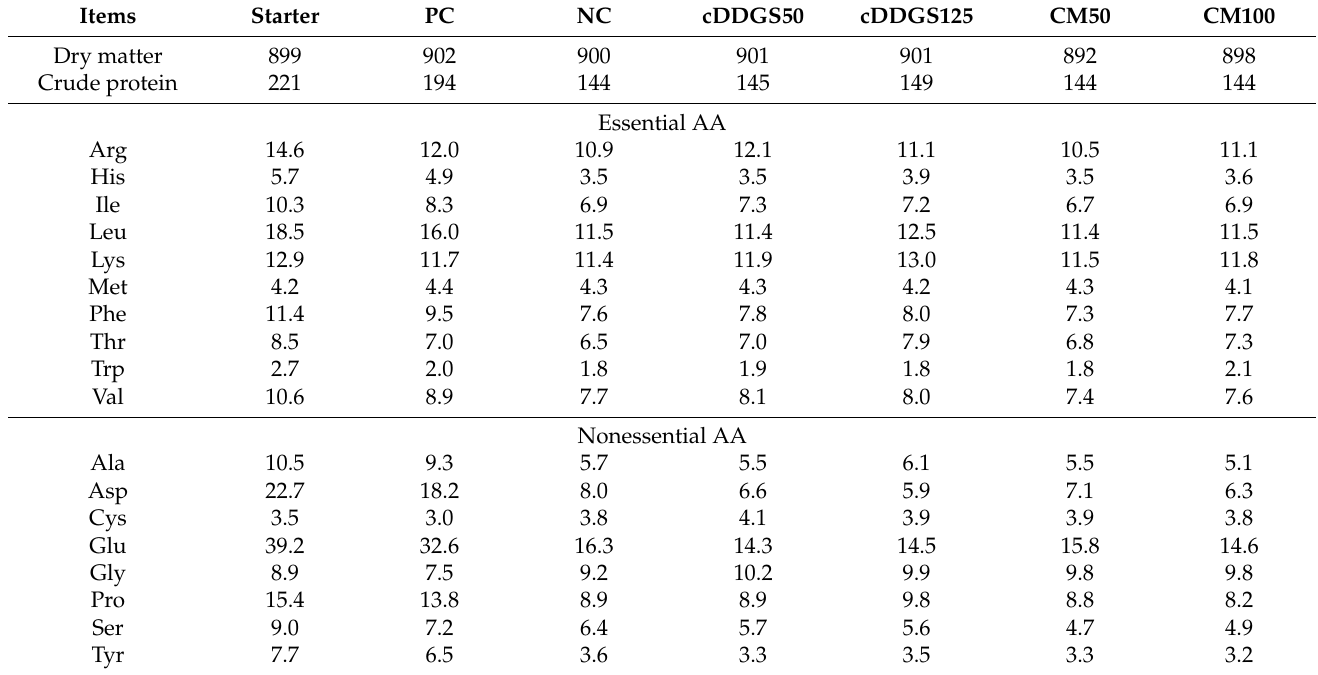
Table 5. Analyzed crude protein and total amino acids content (g/kg, as fed) of experimental starter grower phase diets (day 10 to 28) fed to broilers receiving diets containing soybean with reduction in crude protein or low-protein diets with serial inclusion levels of canola meal or corn–DDGS supplemented with crystalline amino